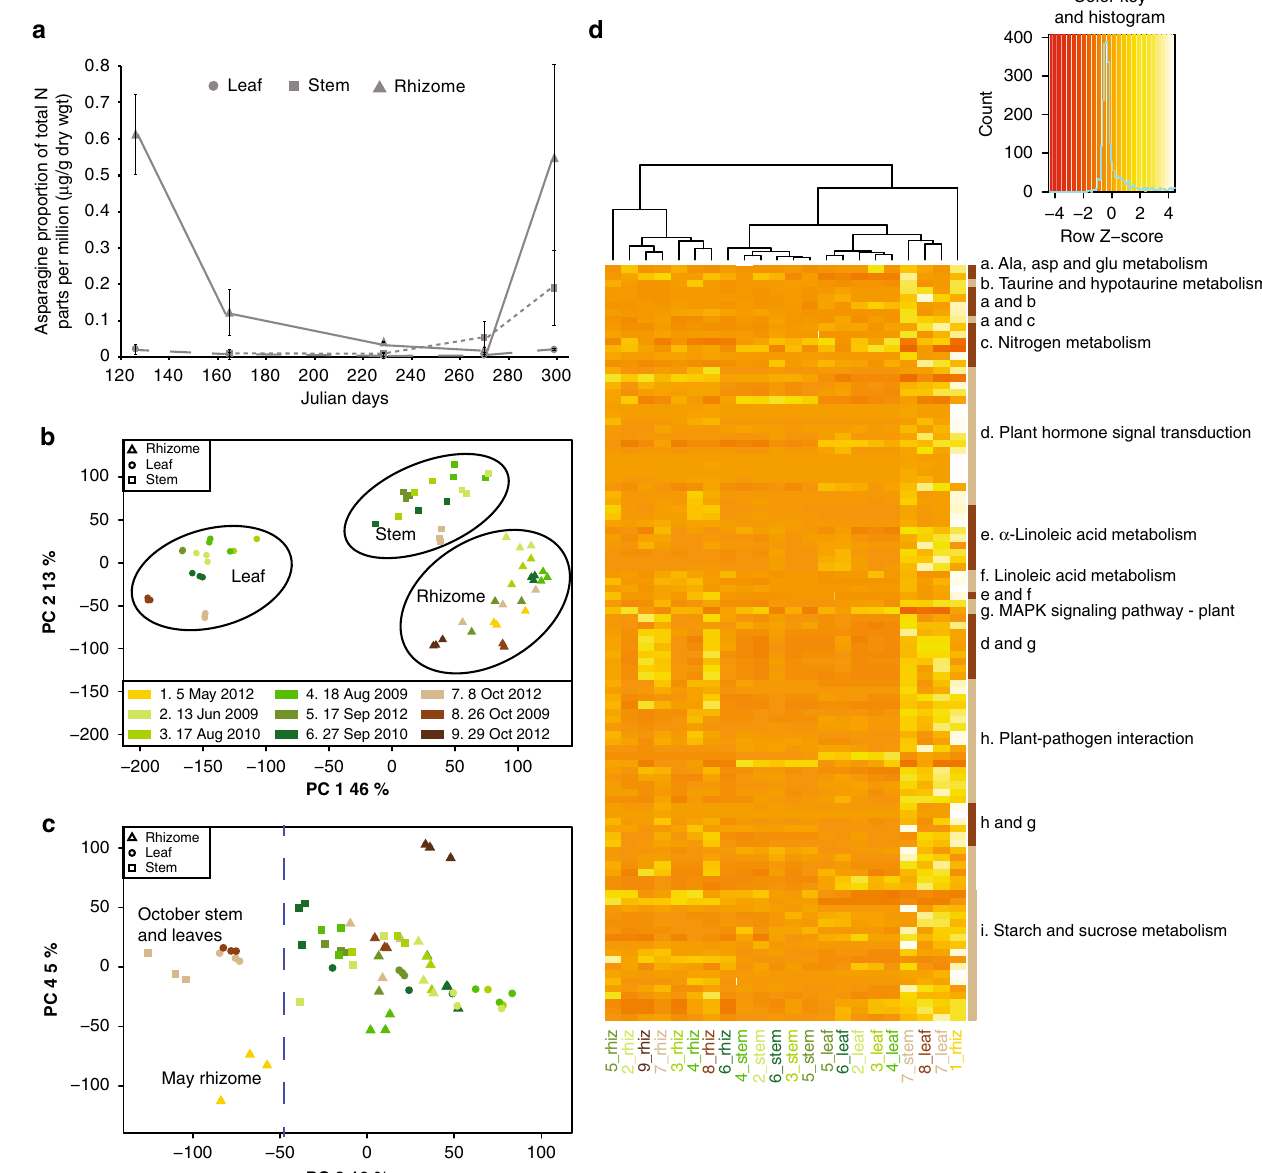
Fig. 4 Seasonal gene expression changes in miscanthus. a Shows asparagine in rhizome, stem, and leaves over the growing seasons normalized to total nitrogen in the sample. The error bars represent the standard deviation. b Principal component analysis of RNA-seq read counts normalized using the DESeq2 variance-stabilizing transformation method. PC1/2 distinguishes the three tissues from each other. c PC3/PC4 separates samples based on their nutrient mobilization status. The color scheme for the organs and dates matches b . d Heatmap across all tissues in the study comparing the expression of a subset of genes expressed in tissues that are actively remobilizing nutrients. Source Data are provided as a Source Data fi